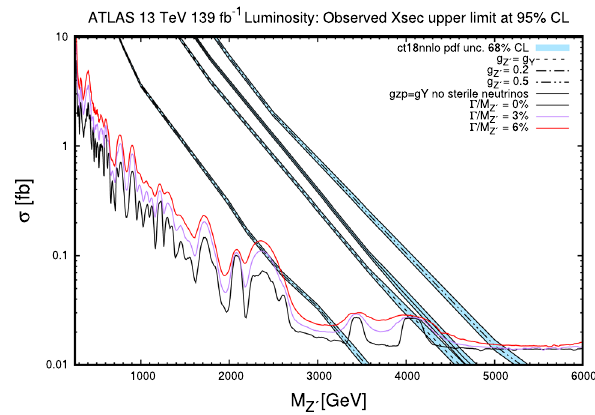
Fig. 10 Observed 95% CL upper limits on the total cross section as a function of the Z (cid:2) mass at ATLAS 13 TeV [67]. The theory predictions for the total inclusive cross section is evaluated at NNLO in QCD using CT18NNLO PDFs. The induced PDF uncertainty represented by the blue bands is at the 68% CL